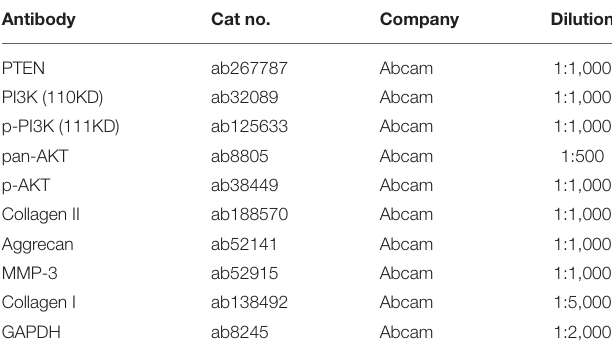
TABLE 2 | Primary antibodies used in Western blot. Antibody Cat